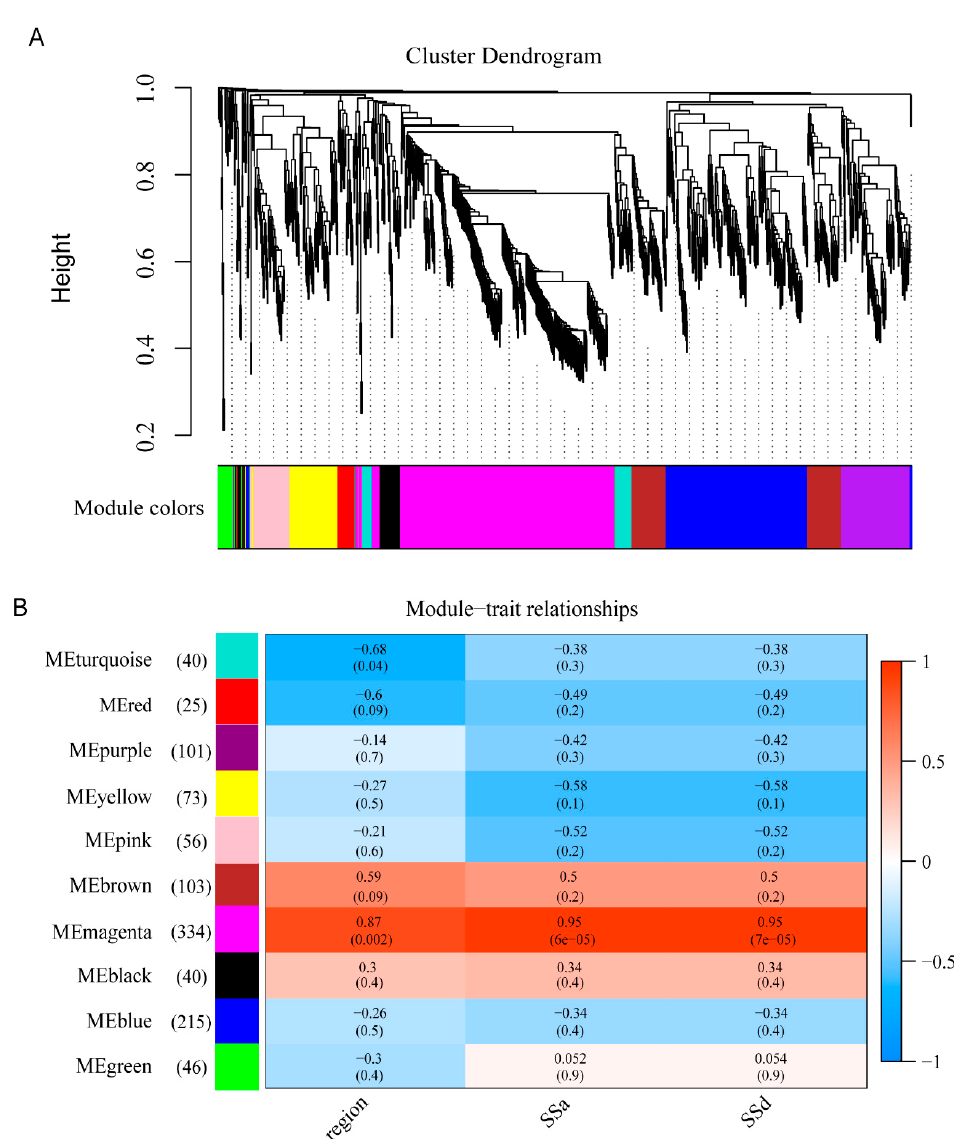
Figure 2. WGCNA. Hierarchical gene clustering was used to sort out the clustering tree of the co-expression network module according to the 1-tom matrix. Each module used a dissimilar color. ( A ) The hierarchical dendrogram displays co-expression modules revealed by WGCNA. One gene is represented by one leaf. Ten modules were found and assigned with different colors based on the calculation of eigengenes. ( B ) Correlation between traits (bottom) and modules (left), with numbers in left brackets showing the gene number of the module. Blue and red represent negative and positive correlations, respectively, and coefficient values are shown. The darker the color, the higher the correlation coefficient. The p -values are in brackets.